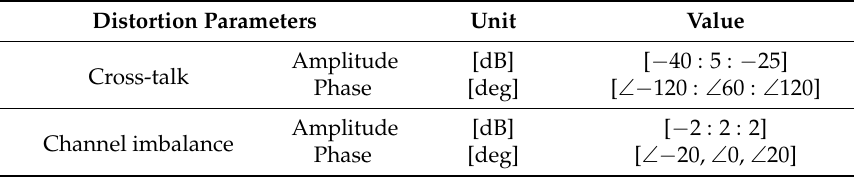
Table 1. The considered distortion parameters for simulation